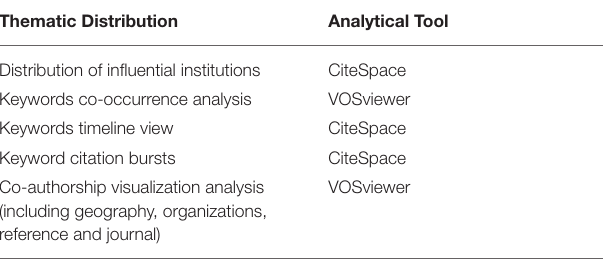
TABLE 1 | Different analytical tools in data